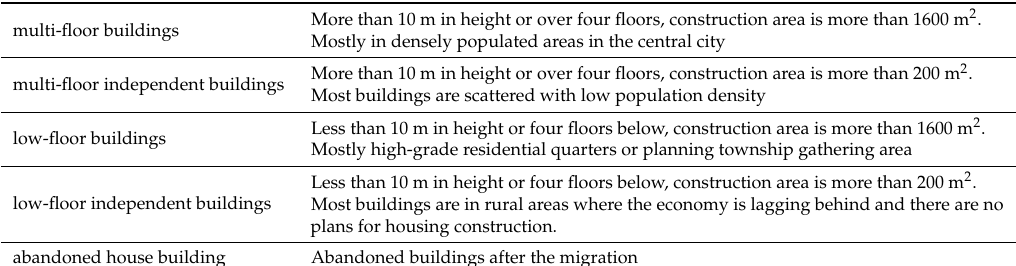
Table 2. Detailed Description of House